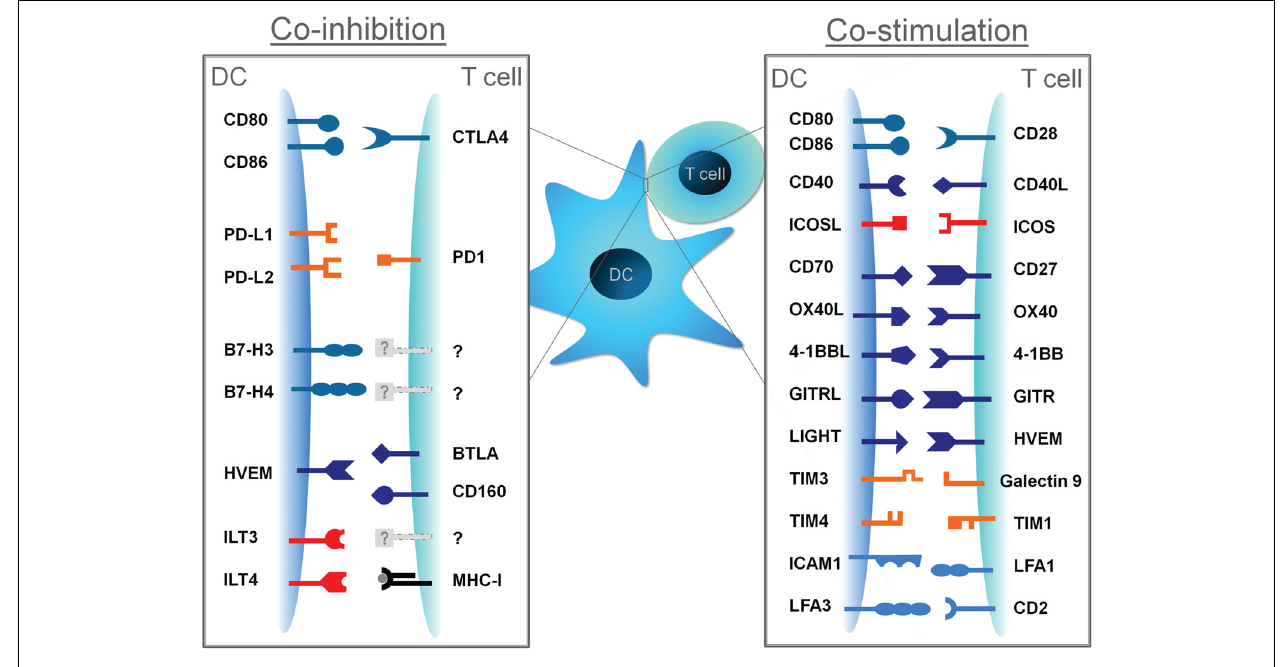
FIGURE 1 | Co-stimulatory and co-inhibitory molecules and their cognate ligands. DC-derived signal II can promoteT cell activation when conveyed by co-stimulatory molecules, or can attenuateT cell responses when conveyed by co-inhibitory molecules.